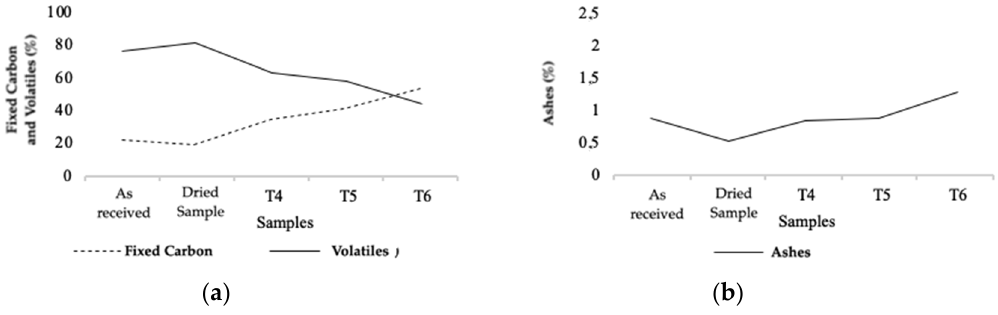
torrefied samples of Series 1. Clean Technol. 2020 , 2 FOR PEER REVIEW